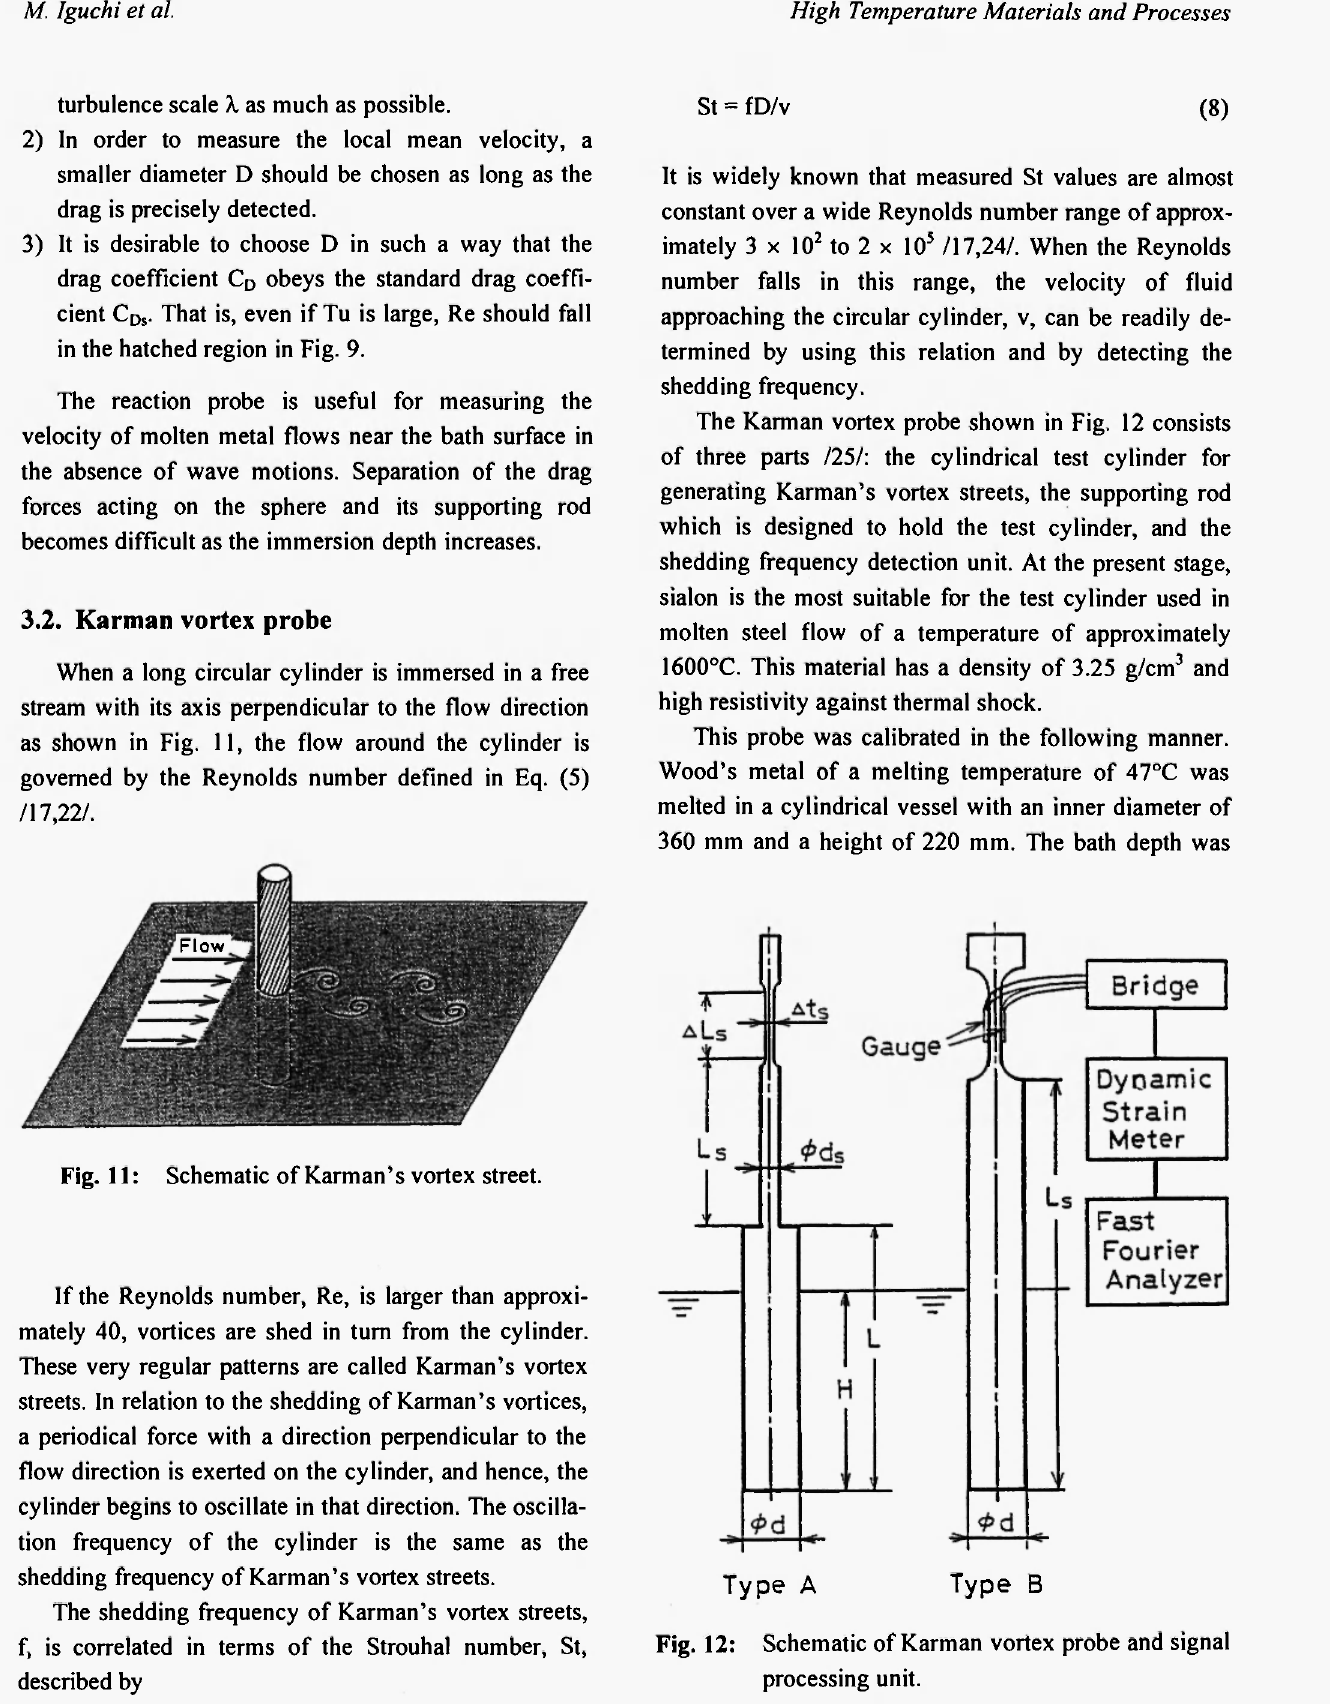
Schematic of Karman vortex probe and signal processing